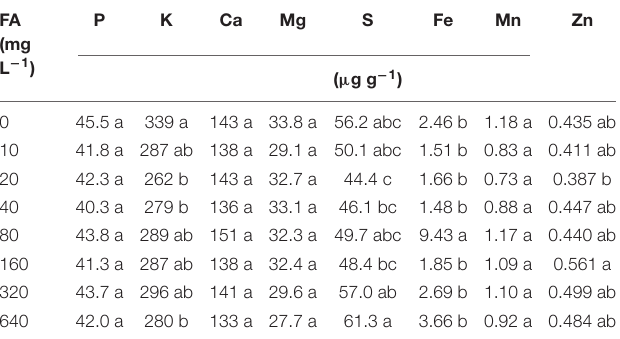
TABLE 7 | The effect of fulvic acids (FA) on nutrient concentration in leaves of tomato plants cv. Zizhenzhu in hydroponics for 21 days from transplanting (Experiment 3).